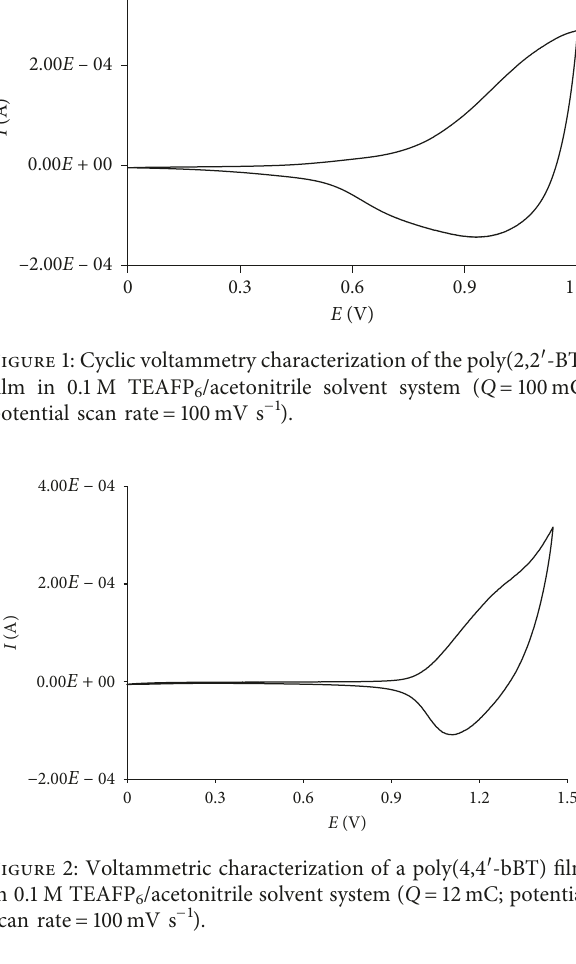
-bBT) film 12mC; potential (cid:30) ′